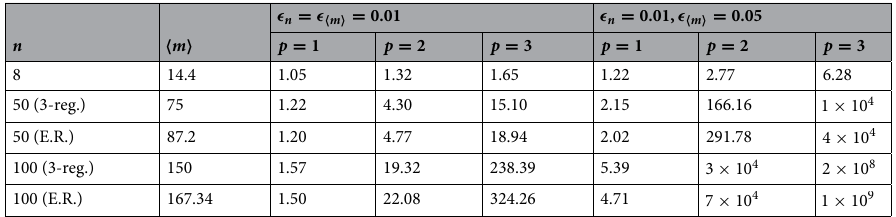
m for (cid:31) (cid:30)